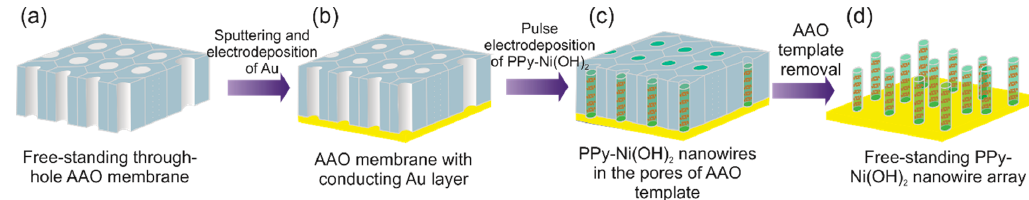
Schematic representation of the synthesis of free-standing PPy-Ni(OH) 2 nanowire array